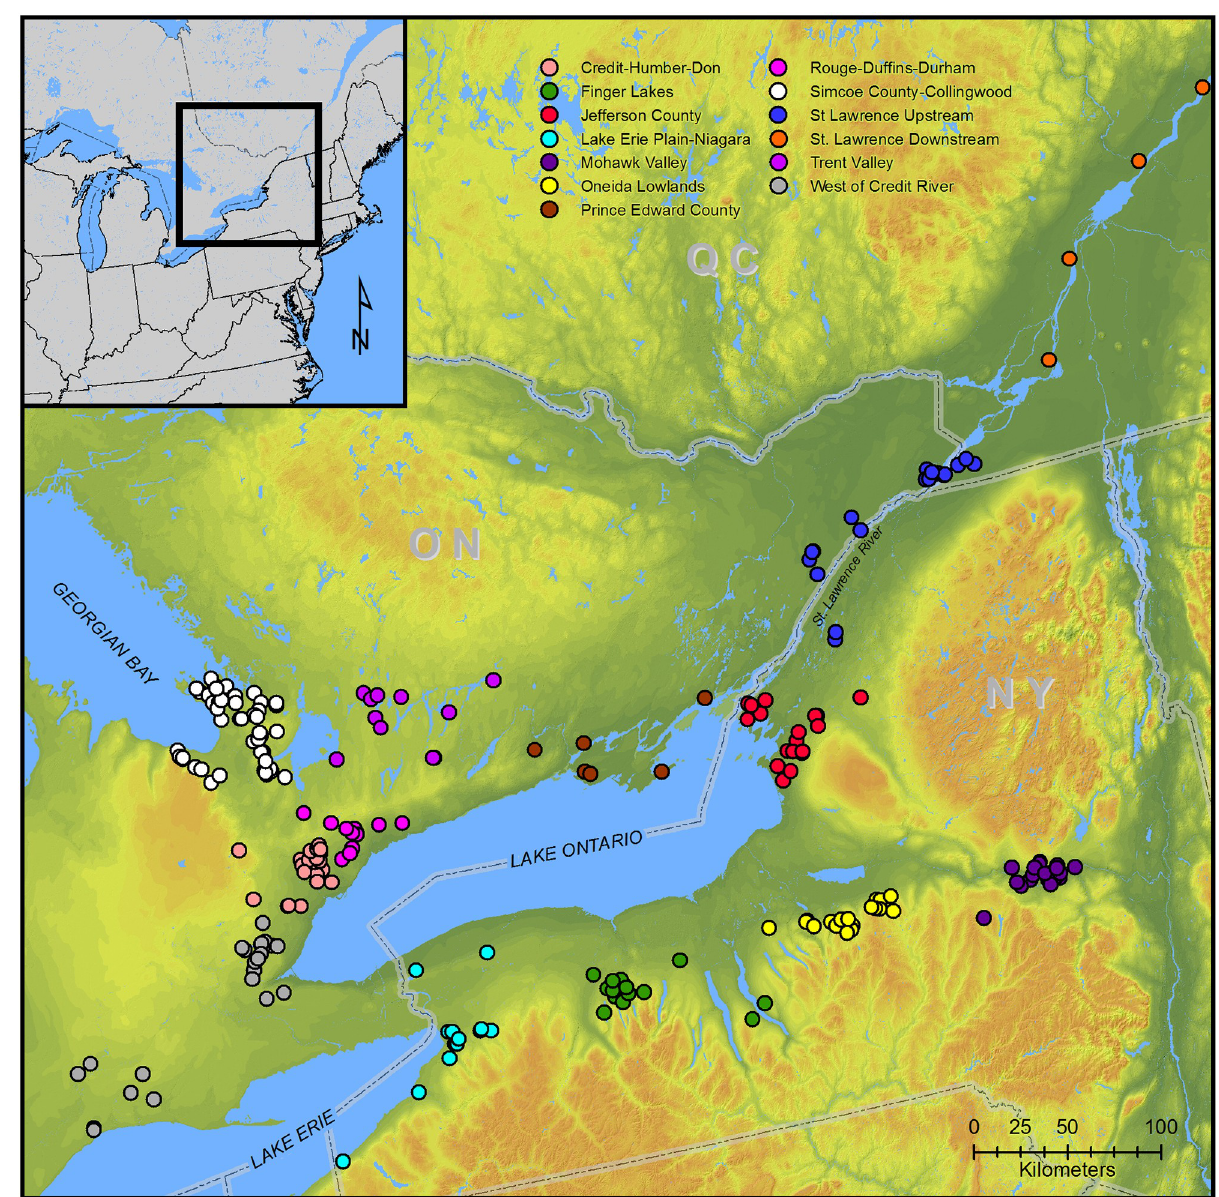
Fig 1. Map showing locations of sites in database keyed to clusters used in the current